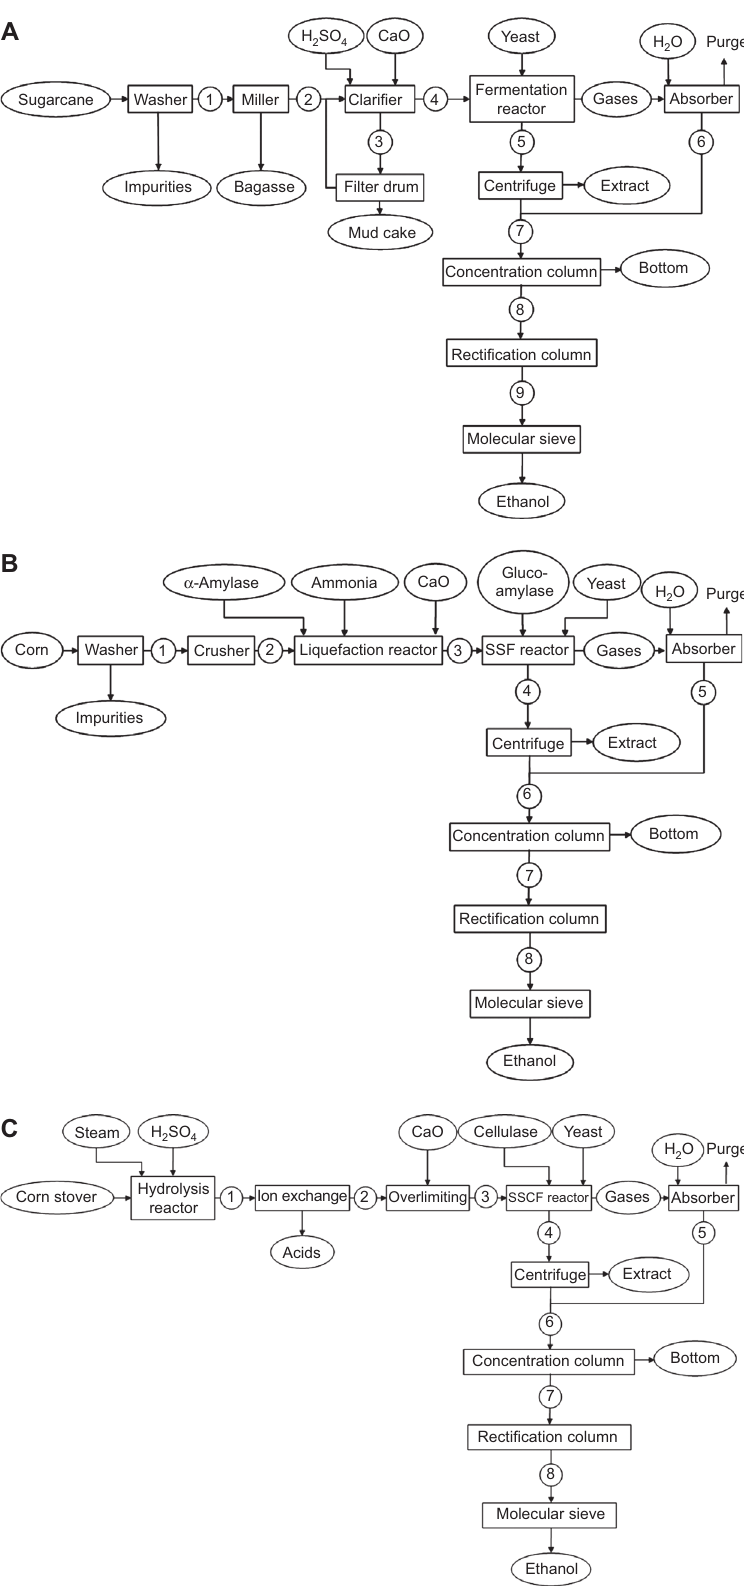
Figure 1 Simplified flowsheets of bioethanol production processes considering the main unit operations and process streams. (A) Sugarcane-derived process [10, 14]. (B) Corn-derived process [1, 14]. (C) Corn stover-derived process [1,